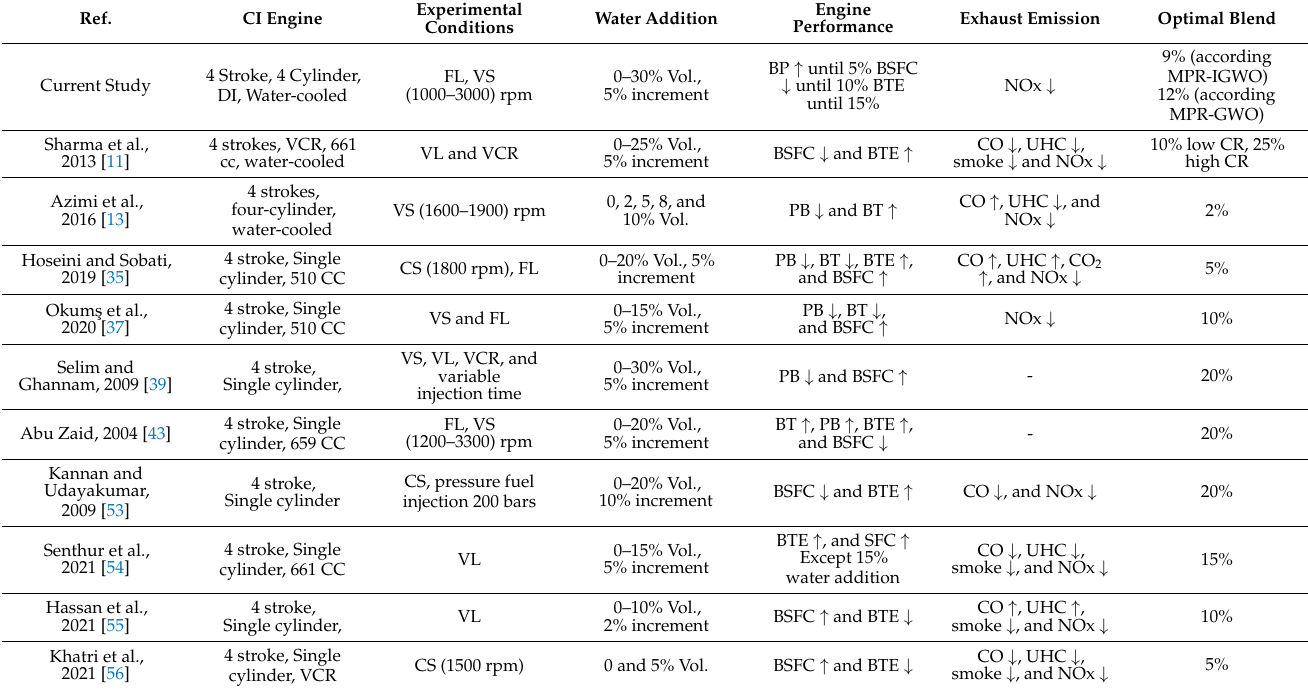
Table 7. Compare the current study to others that employed W/D emulsion in CI engines.